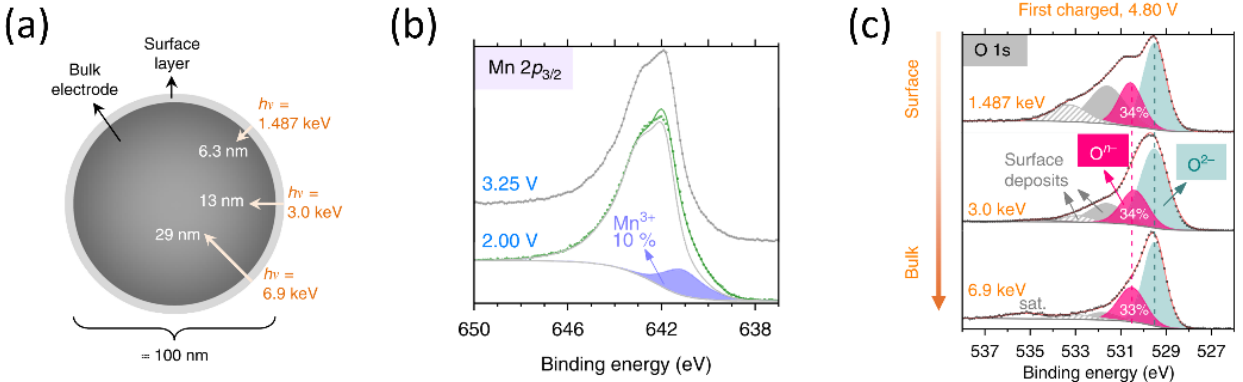
Figure 2. ( a ) The detection depth of HAXPES; The HAXPES of ( b ) Mn and ( c ) O at different charge- discharge states of Li 1.2 Ni 0.13 Mn 0.54 Co 0.13 O 2 . Reproduced with permission from Ref. [21] Copyright 2017, Nature Portfolio.